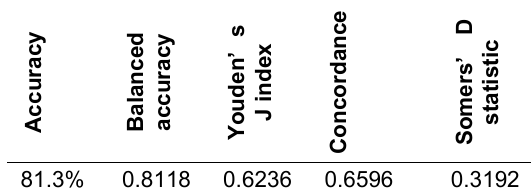
Table 6. Evaluation metrics of SVM with GK